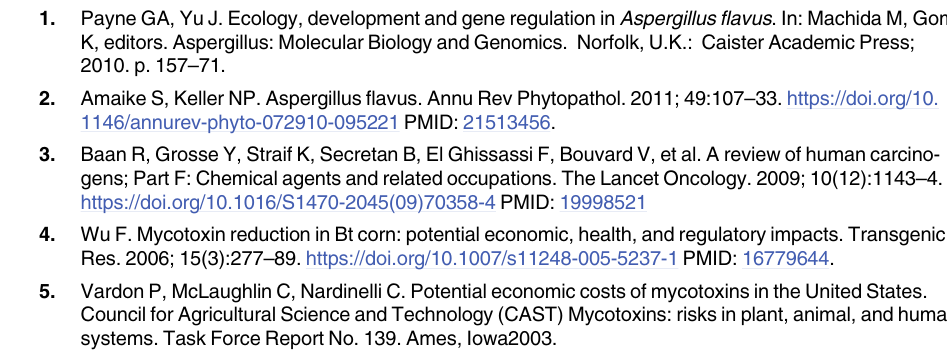
S1 Table. Gene Ontology enrichment. GO categories of genes that are unique to strains AF70 and NRRL 3357. S2 Table. SNP analysis. Comprehensive list of SNPs identified in AF70 and NRRL 3357 afla- toxin gene